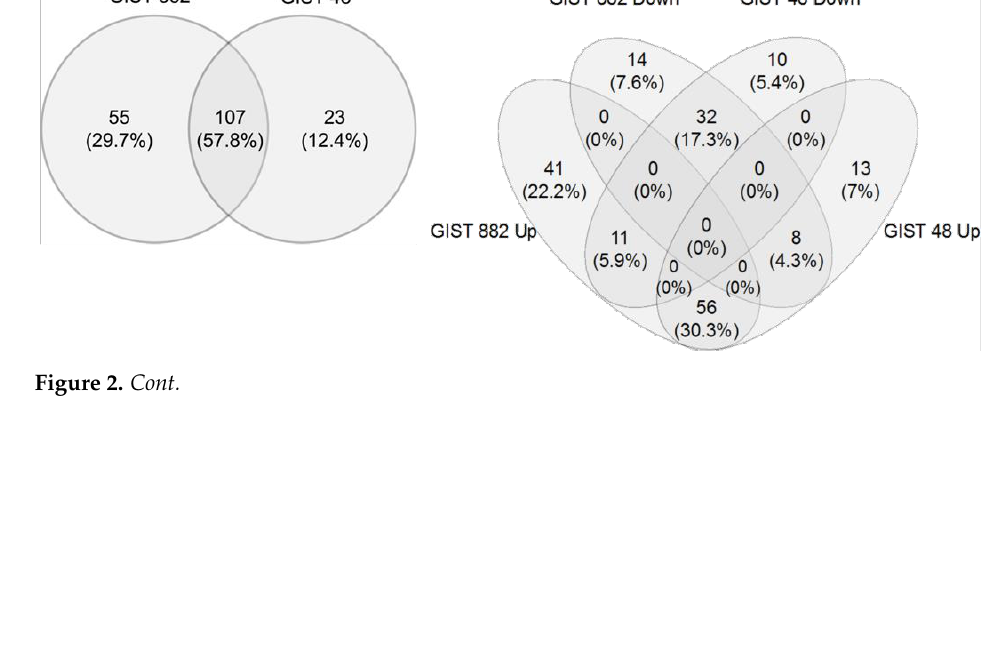
Figure 1. Reduced levels of ETV1 and MITF in SH3BP2-silenced GIST cells. GIST882 and GIST48 were transduced with control NT (Non-target) shRNA and SH3BP2 shRNA. Cell lysates were analyzed on the 7th day post-transduction for MITF, ETV1, and SH3BP2. β -actin was used as a loading control.